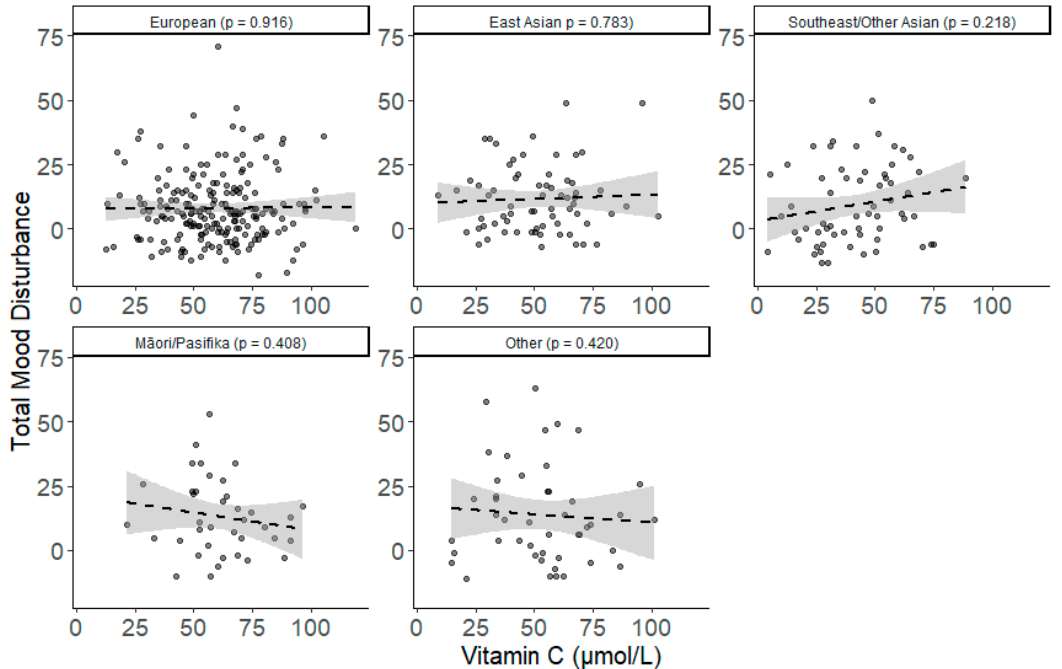
Figure 4. Simple scatterplots of the unadjusted relationship between vitamin C and Profile of Mood States (POMS) Total Mood Disturbance between different ethnic groups (Europeans, East Asians, Southeast/Other Asians, M ā ori/Pasifika and Other). Dashed line indicates the line of best fit. Grey shading indicates 95% confidence intervals. p values for fully adjusted simple slopes.